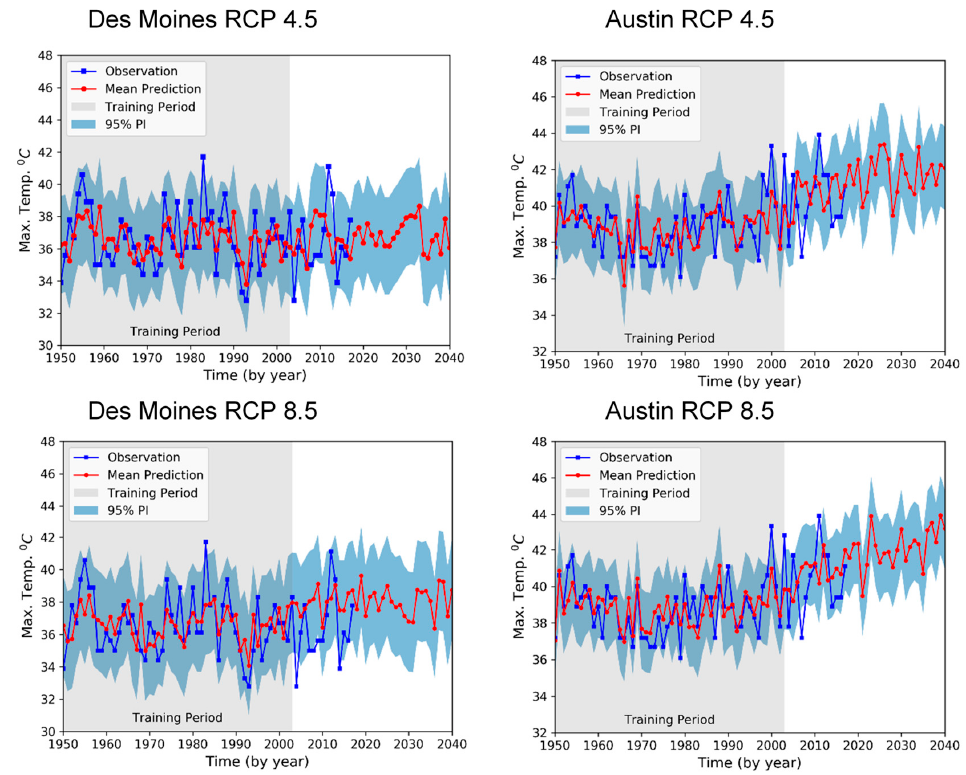
Figure 4. Annual mean peak temperature predictions (red lines) with envelope for 95% PI (aqua) and observed annual maximums (blue lines) from 1950 to 2017 for Des Moines and Austin. Predicted values are based on RDC projections of RCP 4.5 (top) and 8.5 (bottom) climate scenarios.